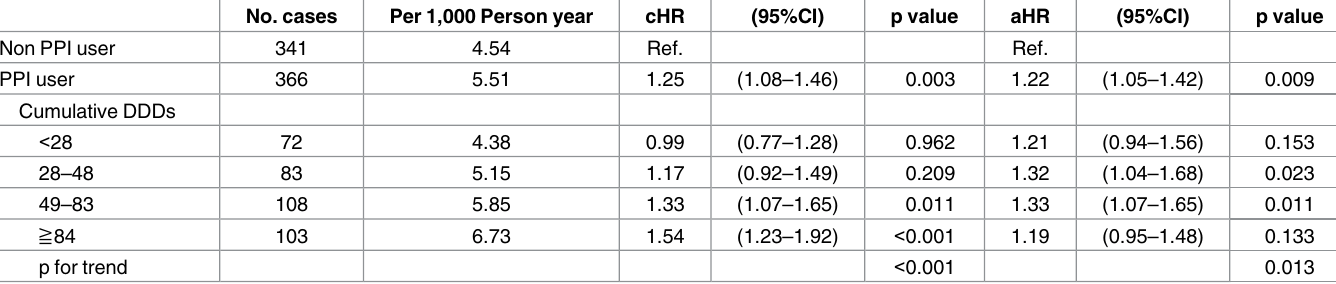
Table 2. Risk of all-cause dementia among non—PPI users and PPI users (N = 15,726). No.